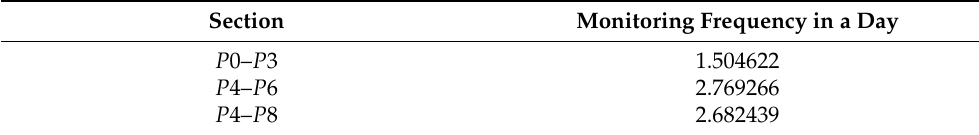
Table 5. Monitoring frequency in a day for the configurations P 0– P 3, P 4– P 6 and P 4– P 8.